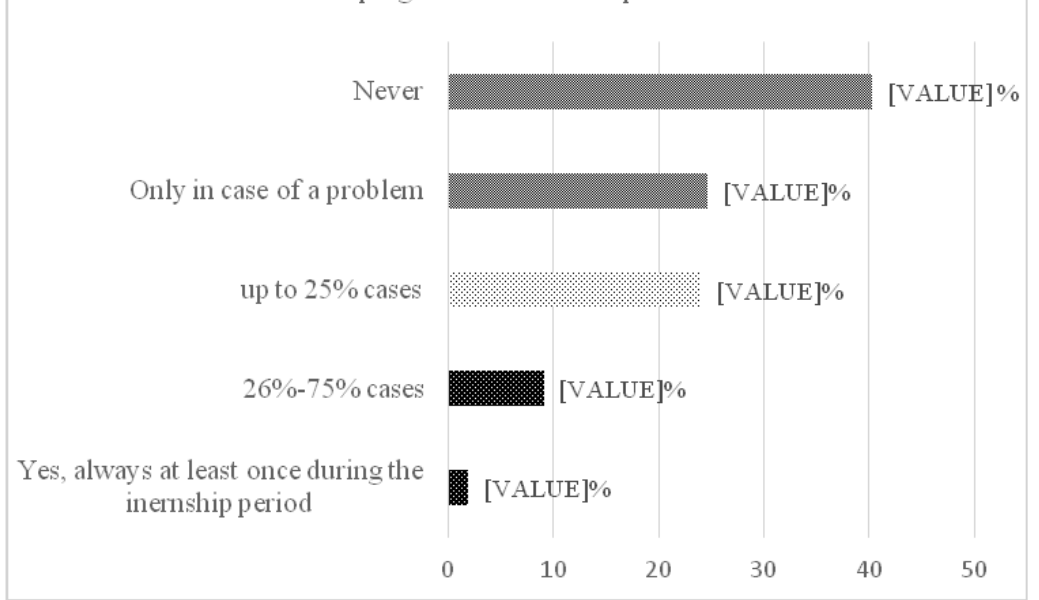
Figure 1 . Cooperation between company and higher education institution during internship.